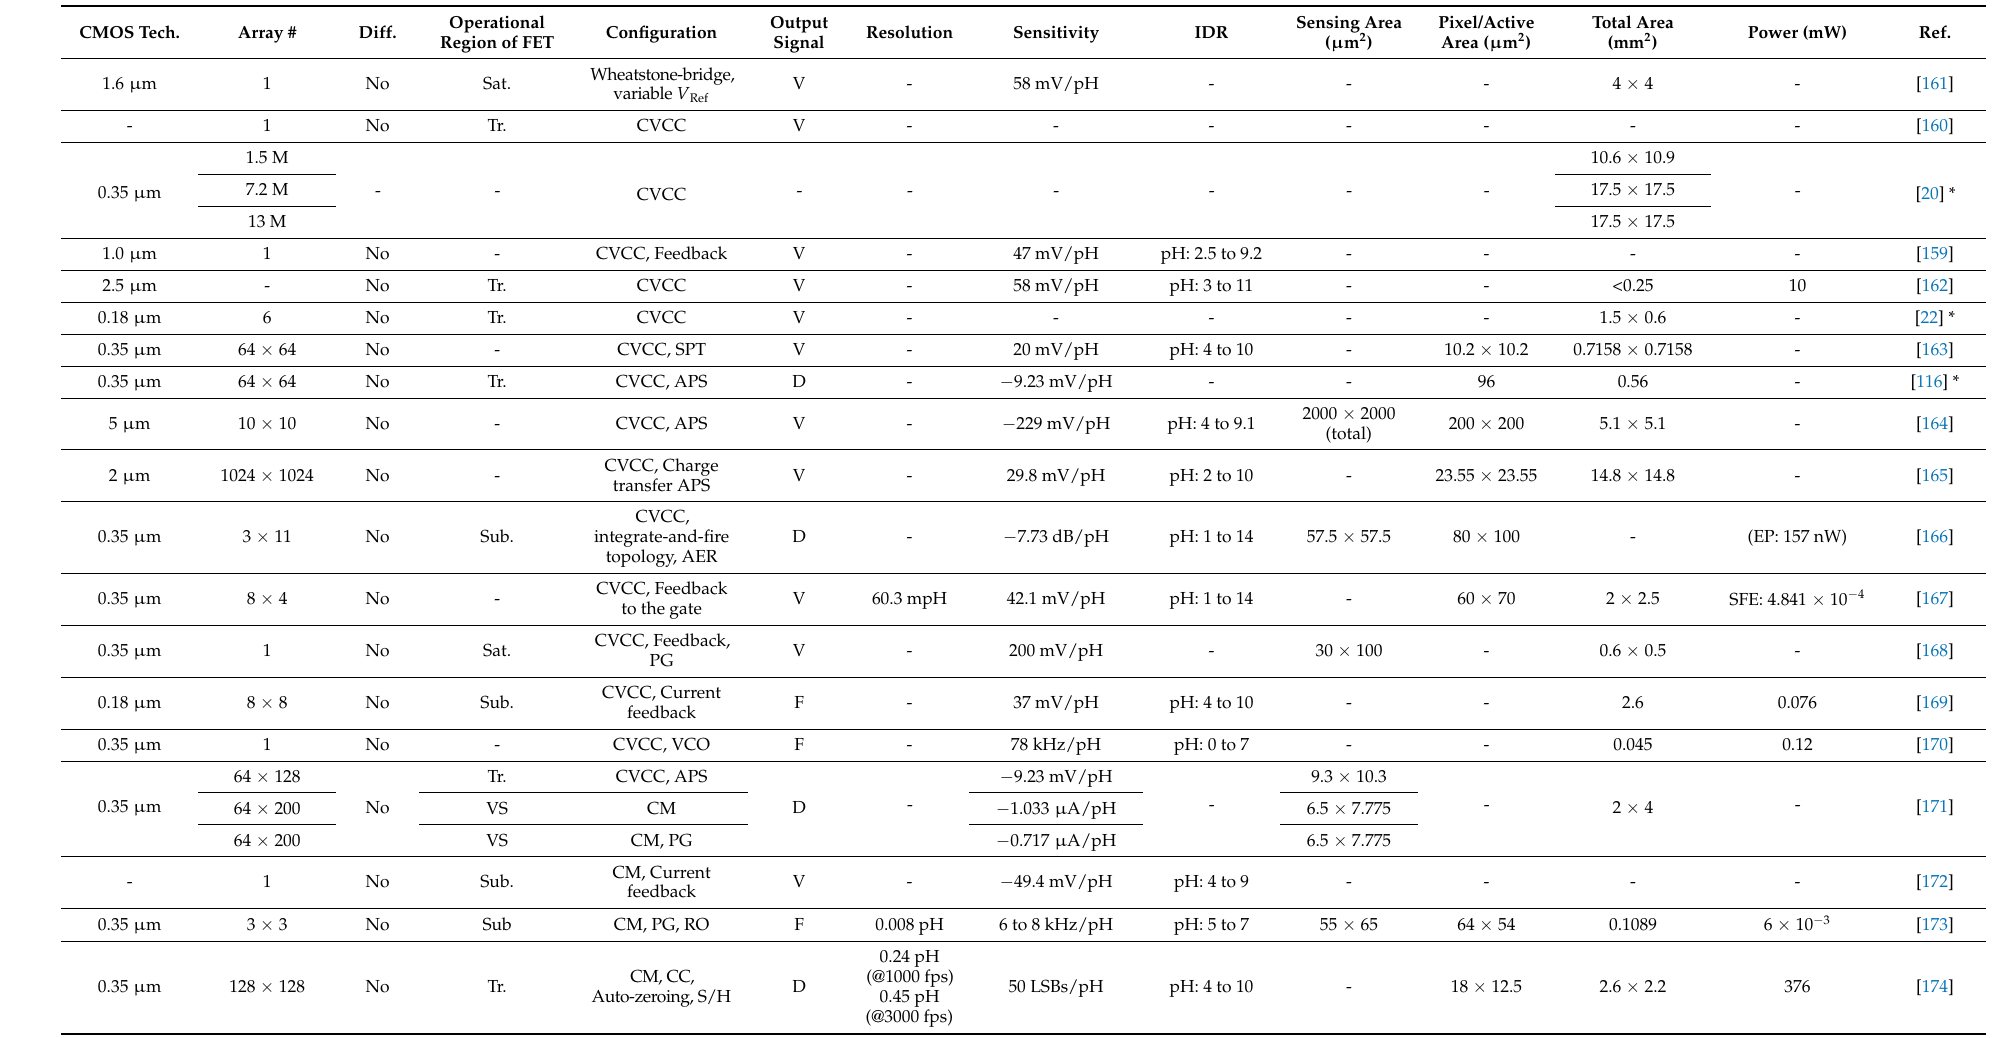
Table 2. Different readout circuits for Chem/BioFET